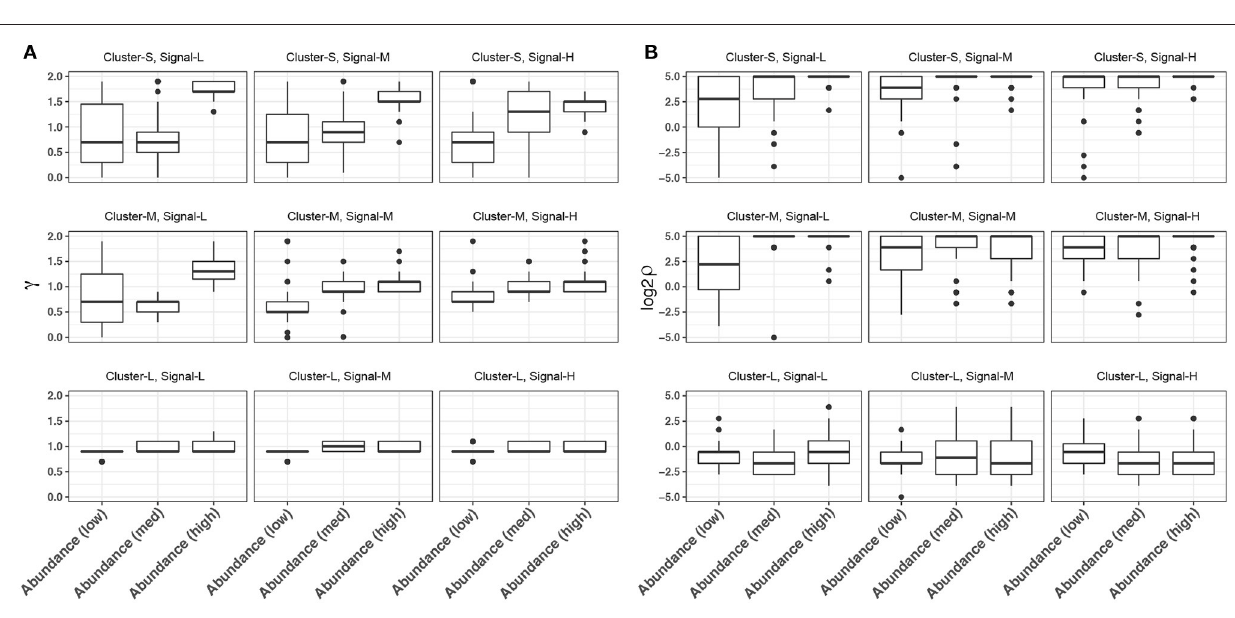
FIGURE 3 | Distribution of the selected tuning parameter γ (A) and ρ (B) across different levels of cluster size, signal density and abundance for continuous-outcome simulations. Cluster-S, -M, and -L represent small, medium and large clusters, and Signal-L, -M, and -H represent low, medium and high signal density,